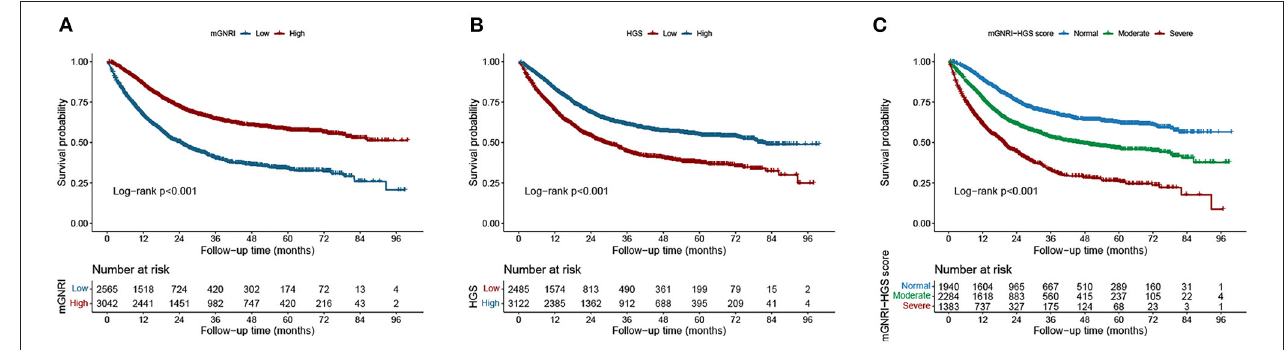
FIGURE 1 | Kaplan-Meier curve of mGNRI, HGS, and mGNRI-HGS score in patients with cancer. (A) , mGNRI; (B) , HGS; (C) , mGNRI-HGS score.